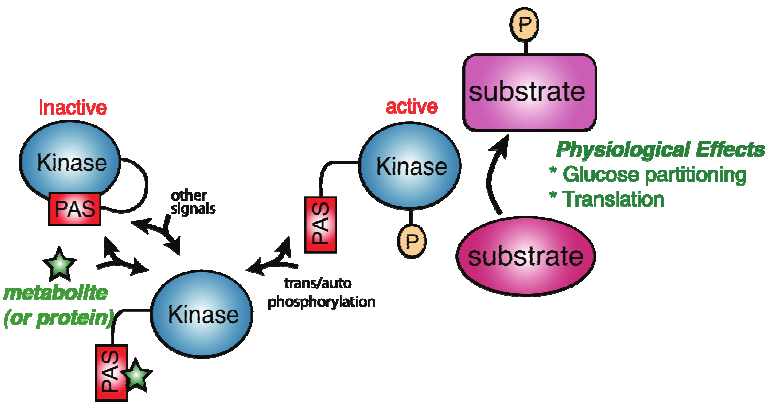
Figure 1. A model for PAS kinase regulation and function. The PAS domain binds to and inhibits the kinase domain. A metabolite (green star) or protein activates PAS kinase